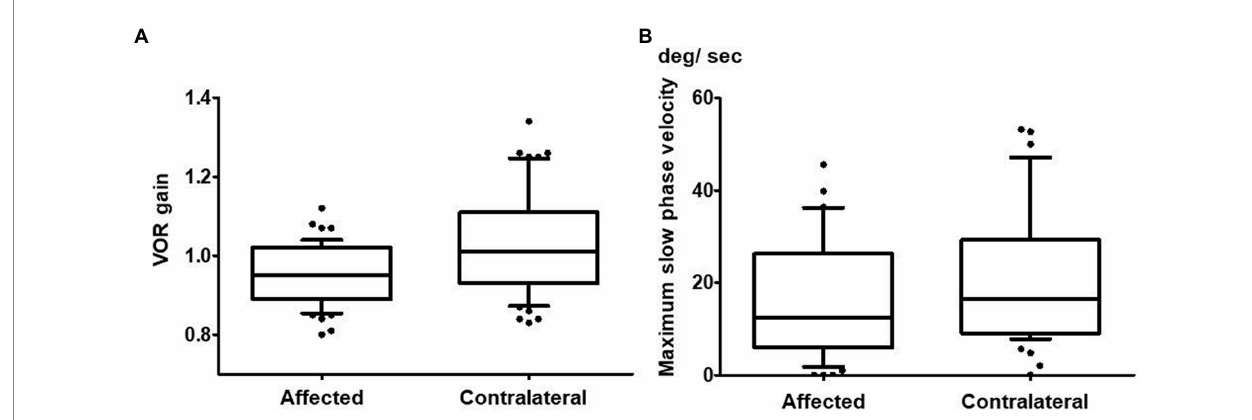
FIGURE 2 Vestibulo-ocular reflex (VOR) gain in vHIT and maximum slow phase velocity in the caloric test of the affected horizontal canal and the contralateral horizontal canal. (A) The mean VOR gain of the horizontal canal on the affected side was 0.95 ± 0.08 while it was 1.03 ± 0.13 for the horizontal canal on the contralateral side in vHIT ( n = 51). This difference was significant ( p < 0.001). (B) The maximum slow phase velocity on the affected side (17.9 ± 17.8 degrees/s) was significantly smaller than that on the contralateral side (21.3 ± 16.6 degrees/s) in the caloric test ( p = 0.020; n =